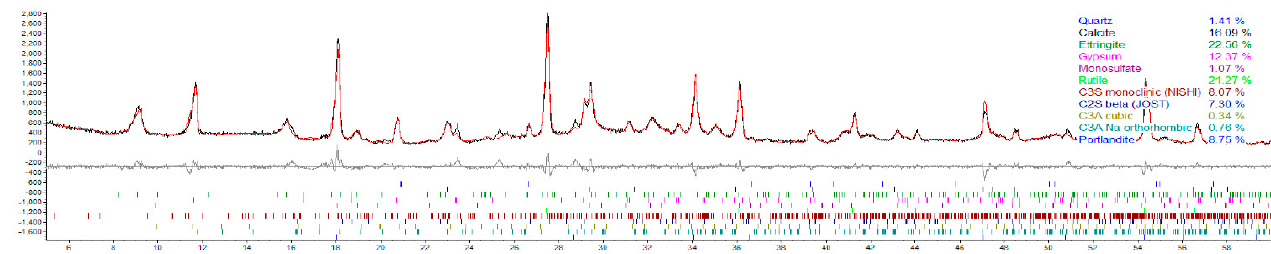
Figure 9. Rietveld analysis for control mixture (C1-Cont) after 1 year exposure in 5% Na 2 SO 4 .